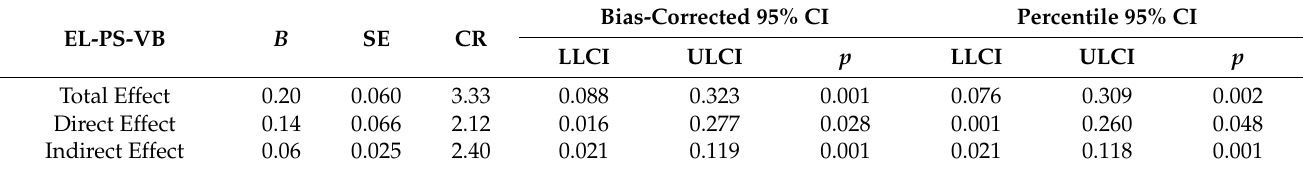
Table 4. Mediation analysis.